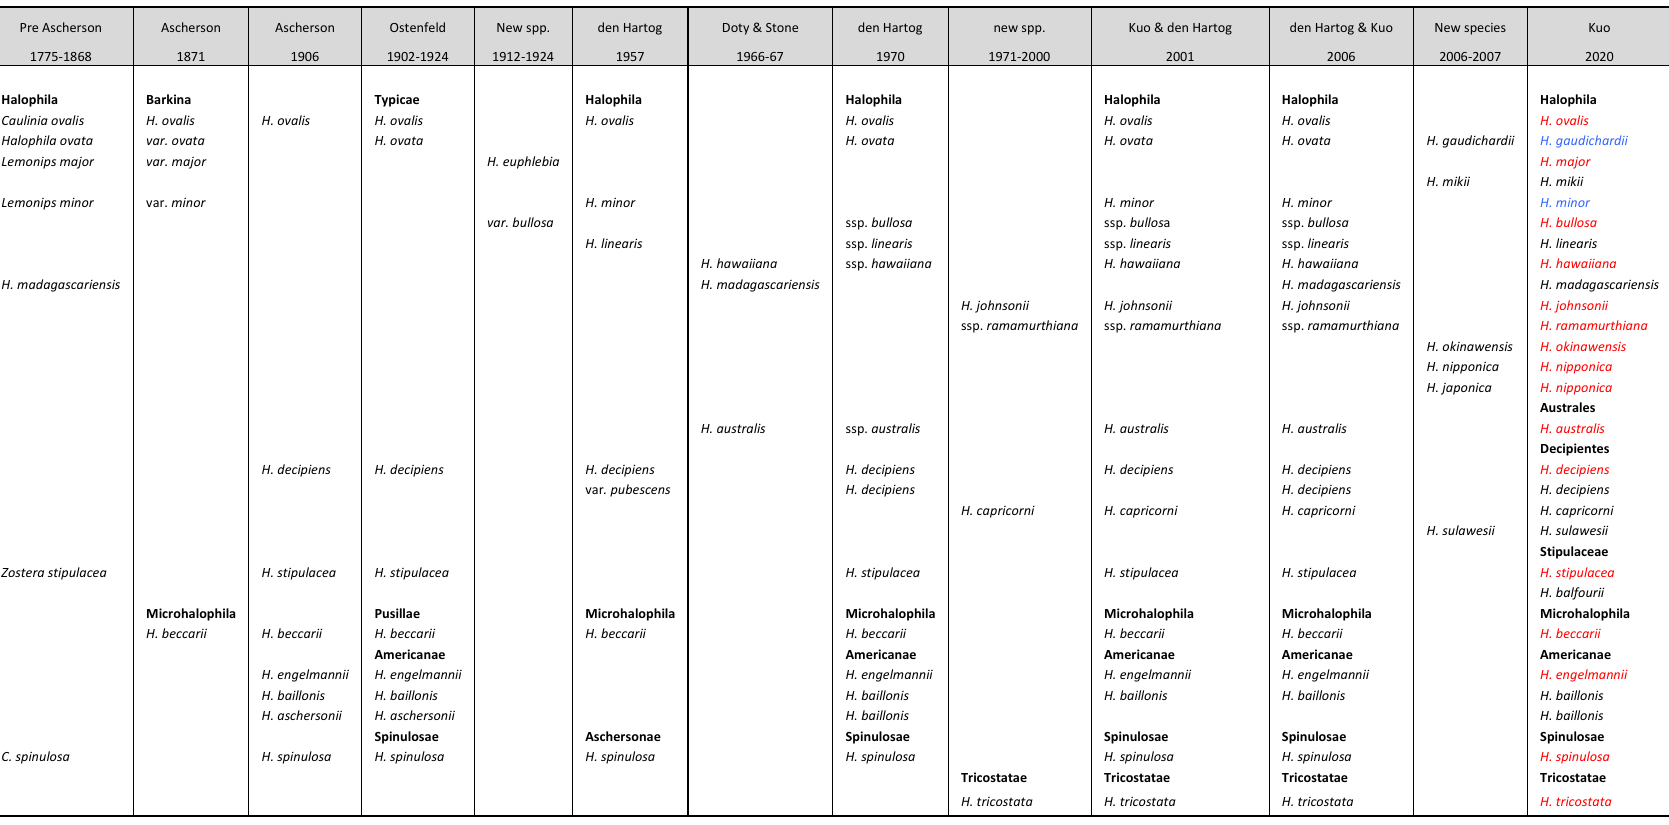
Legend: Vertical columns are years, periods, major researchers; horizontal columns are taxonomic species. Bold indicates Sections. italic indicates taxonomic species; var. represent varieties, all for H. ovalis varieties except H . decipiens var. pubescen s. All ssp. indicates all subspecies belong to H. ovalis . Red colour indicates the species had molecular studies; blue colour indicates for the species identification the molecular studies were doubtful.